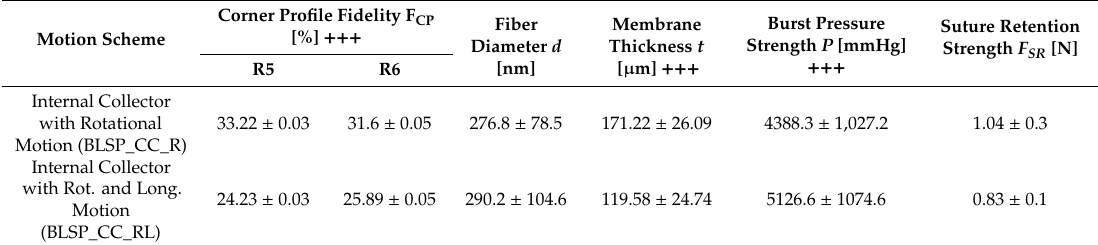
Table 4. Summary of morphology and mechanical